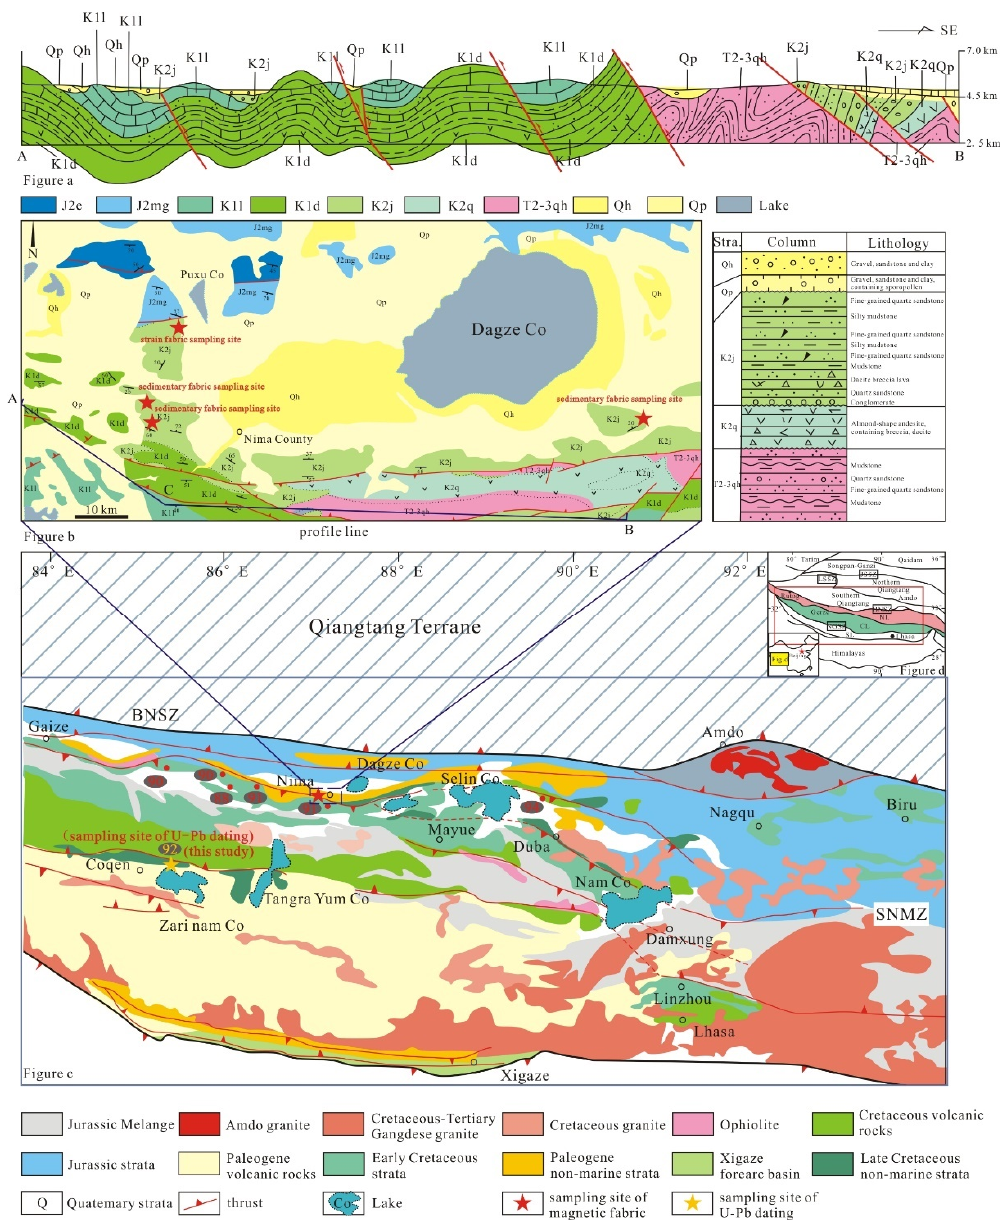
Figure 1. Geological overview map of the study area. ( a ) Distribution of outcrops and location of sampling sites in the study area of Nyima Basin. Contains stratigraphic column and tectonic sections of the study area. ( b ) Distribution of outcrops and location of sampling sites in the study area of Nyima Basin. Contains stratigraphic column and tectonic sections of the study area. ( c ) Distribution of outcrops in the Bangong-Nujiang suture zone and the northern margin of Lhasa. ( d ) Location of the study